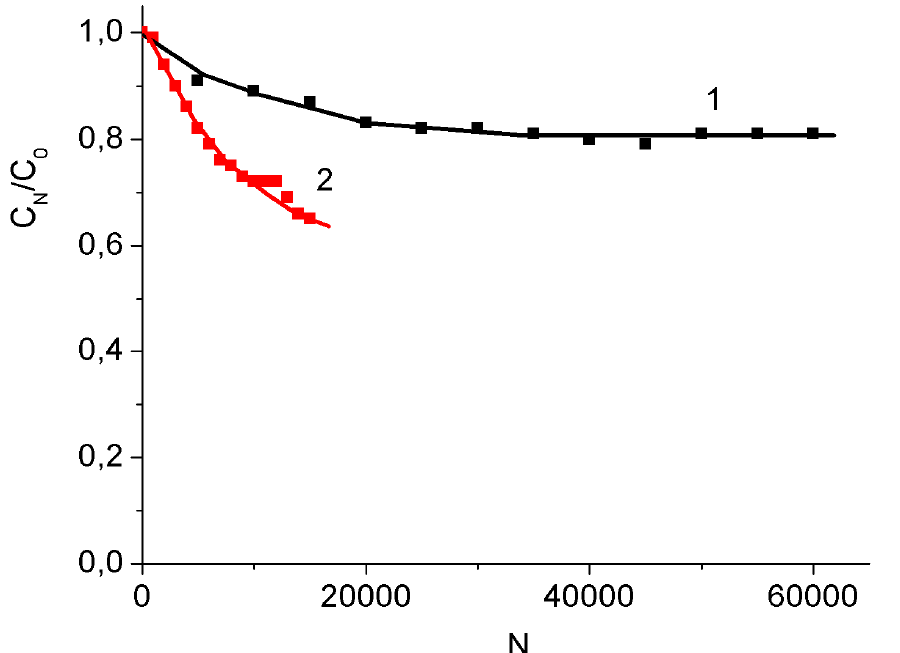
Figure 10. Capacitance evolution during multiple charge-discharge cycling. MnO 2 /MWCNT/Al electrodes from non-oxidized (1) and oxidized (2) MWCNT/Al samples. For comparison, the as-grown MWCNT/Al electrode after 20,000 charge-discharge cycles in a three-electrode cell almost did not lose capacity. In a two-electrode cell, after 20,000 cycles, the capacity loss was approximately 5%